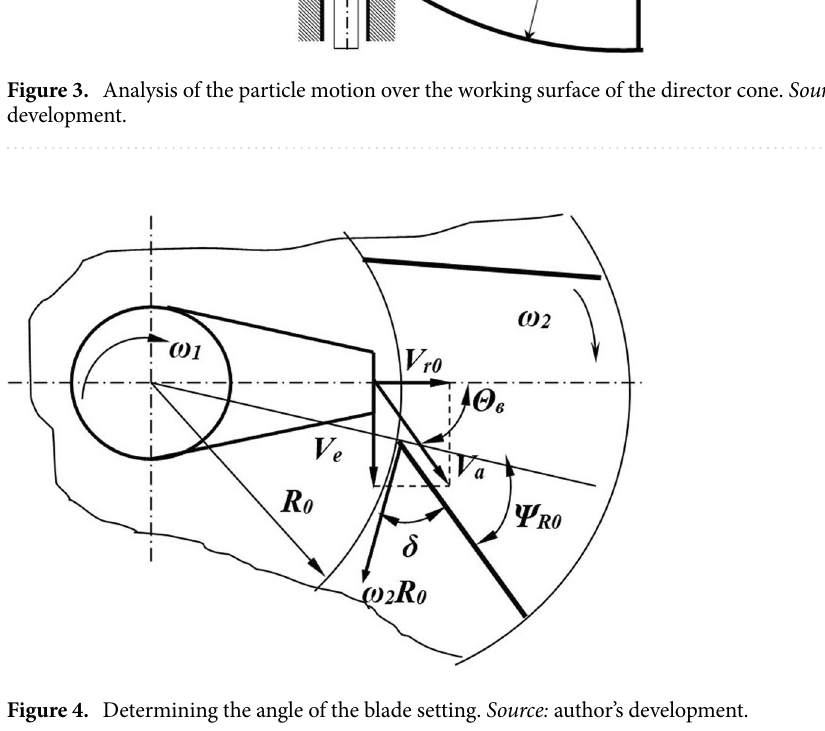
Figure 4. Determining the angle of the blade setting. Source: author’s